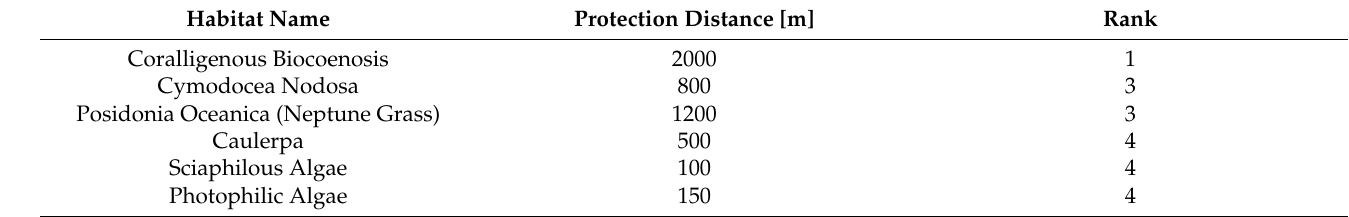
Table A2. Ranks assigned to the habitats data input used for the case study. In this case study, the protection distance parameter was derived through the approach suggested by model developers for cases where there is limited published literature regarding the distance at which habitats can provide protection to the coastline [35]. The values in the middle column therefore reflect the average distance between the location of a given habitat and the shoreline in the given